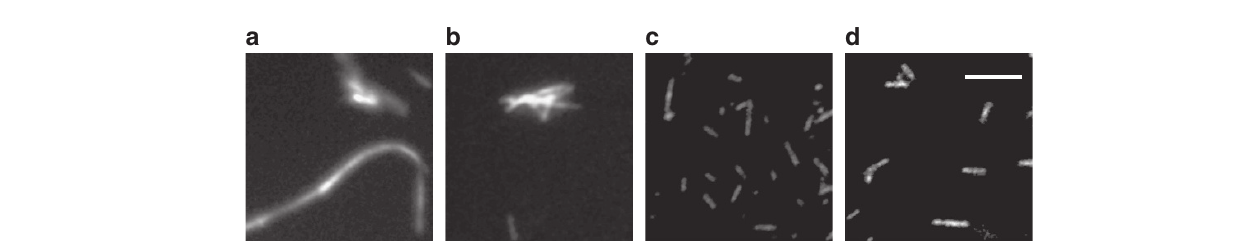
Centralspindlin from in vitro add-back MW, molecular weight.